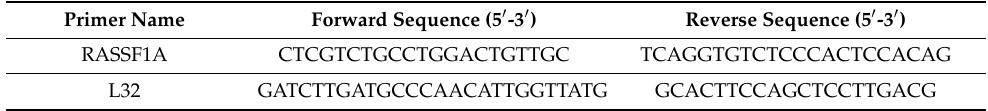
Table 2. Sequences of QPCR primers used in this